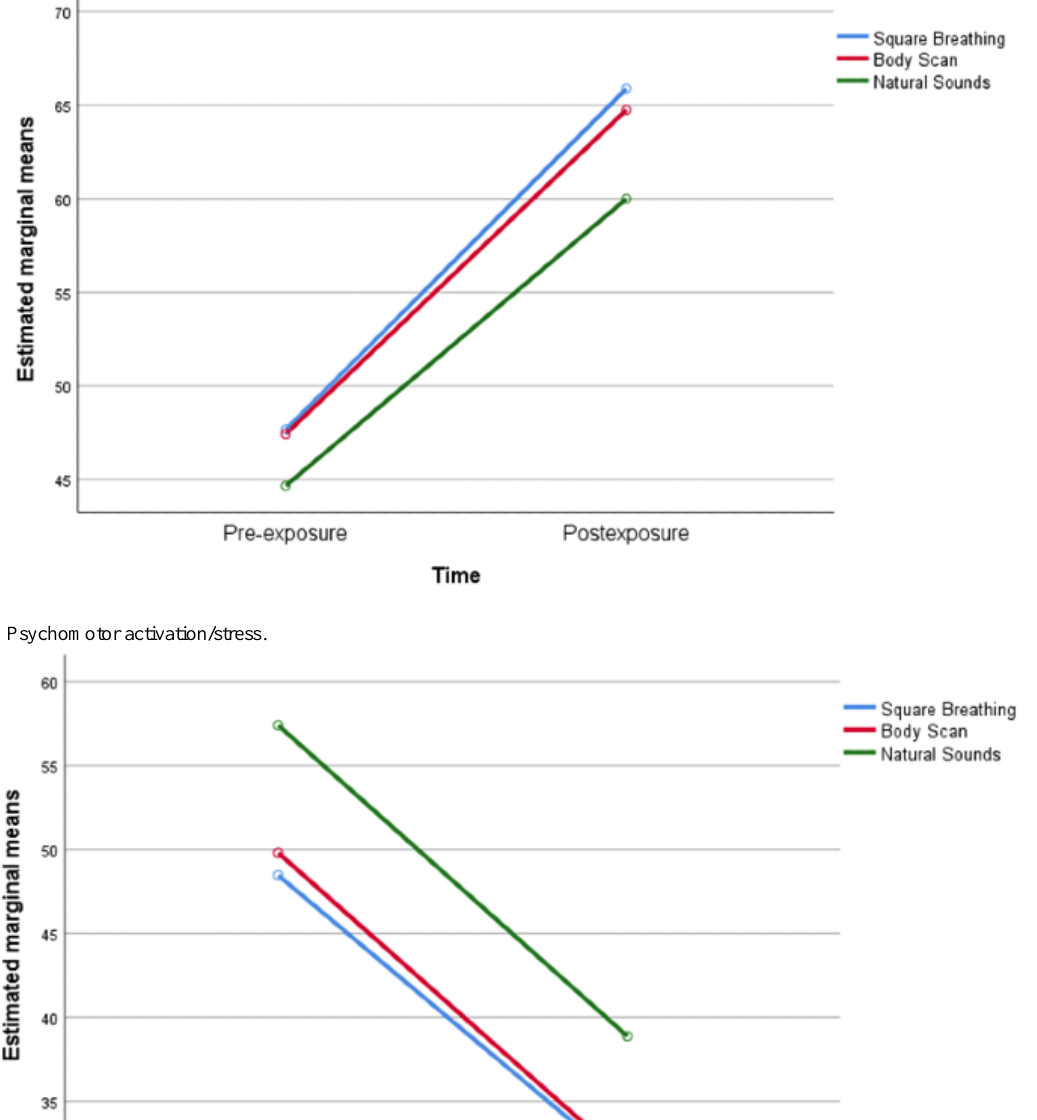
Figure 1. Perceived relaxation.